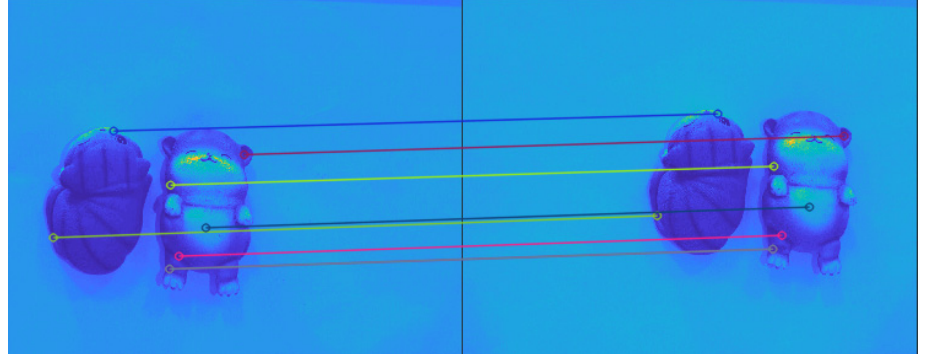
position) algorithm [18].